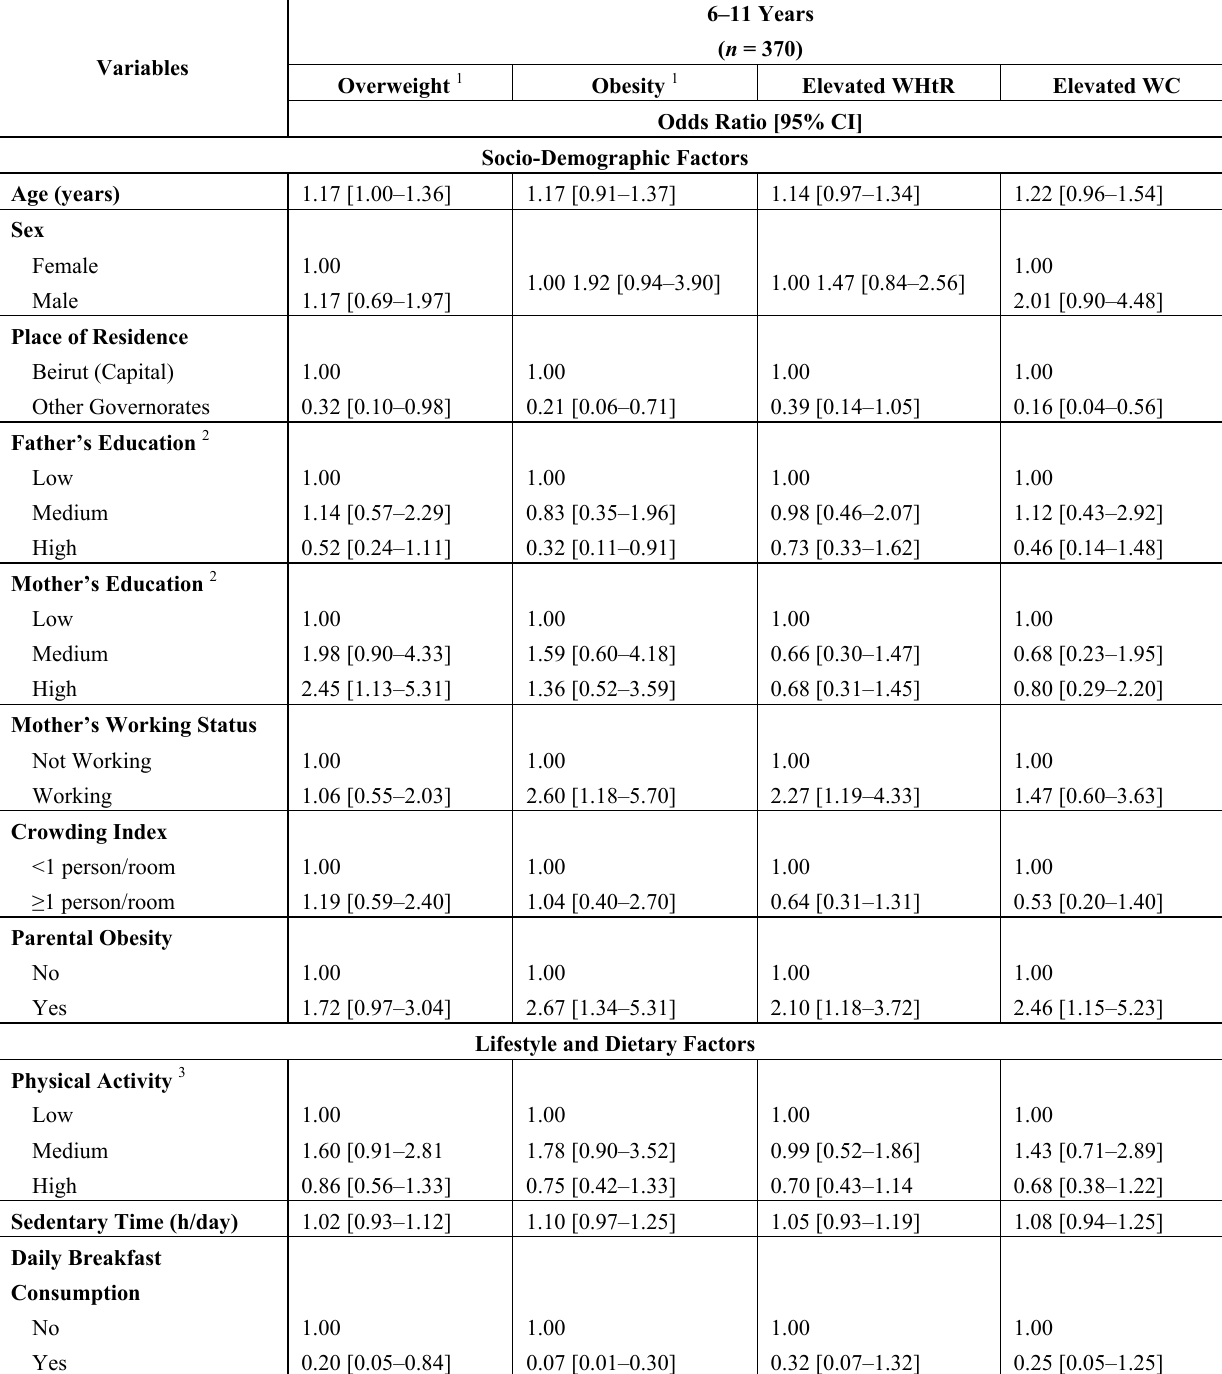
Table 4. Associations of socio-demographic, lifestyle and dietary factors with overweight, obesity, elevated waist to height ratio (WHtR), and elevated waist circumference (WC) in Lebanese 6–11-year-old children ( n =